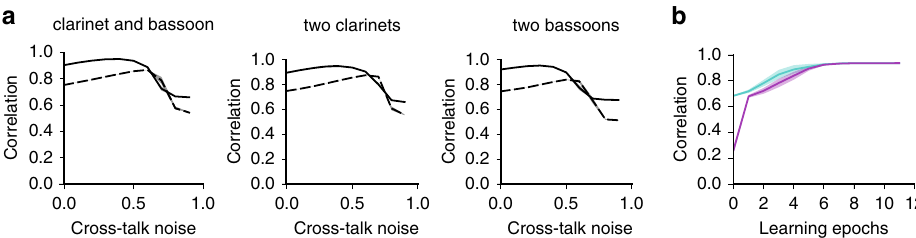
Fig. 8 Robustness of performance in BSS. Curves represent the averages over fi ve trials with different initial weights and different realizations of noise, and shaded areas represent s.d. a Correlations between the original and separated signals are plotted as a function of cross-talk noise (Methods) for where the mixed signals consist of different (left) or identical (middle and right) instruments. The error bars are very small. b Performance is compared between the pre-trained (cyan) and untrained (magenta) network on the original signal. Cross-talk noise in these tests was 0.5. Networks were exposed to 10 s long mixed sounds during each learning epoch and correlations were